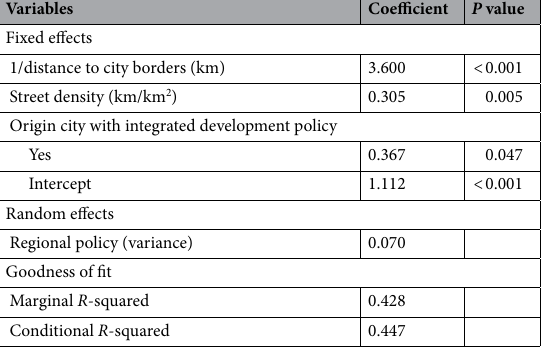
Table 2. Linear mixed model estimates for intercity human movements per